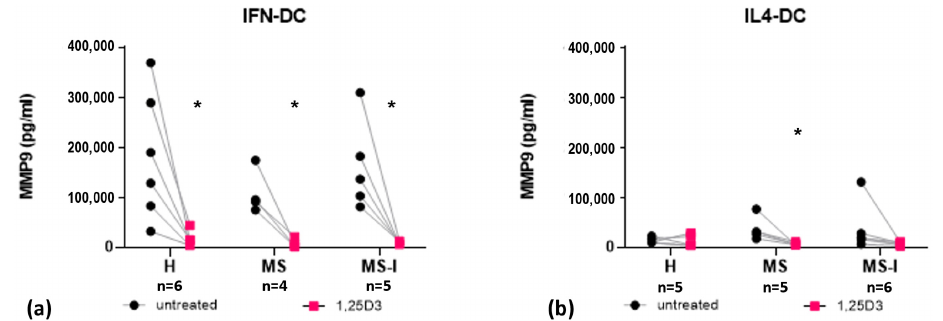
Figure 6. Expression and modulation by 1,25(OH) 2 D3 of matrix-metalloproteinase 9 (MMP9). MMP9